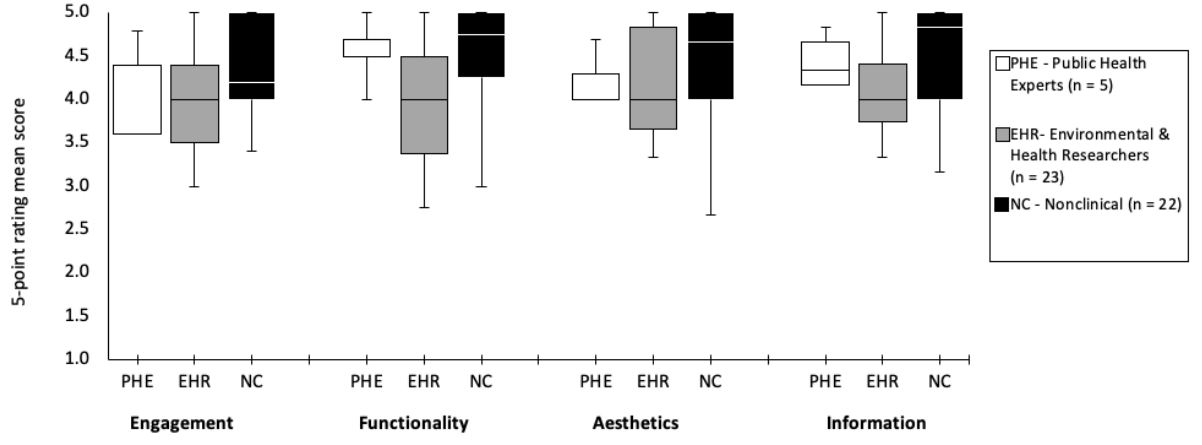
Figure 3. Mean scores of app objective subscales based on the Mobile Application Rating Scale (MARS) from public health experts, environment and health-related researchers, and nonclinical participants.